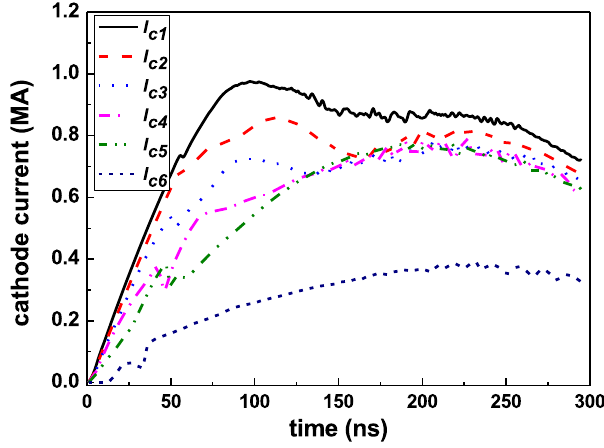
FIG. 6. Cathode currents obtained from PIC simulation. The currents were observed at cathode after each LTD group and after the final conical line for a self-limited magnetic insulation. The declined trend when approaching load indicated more and more current became electron current and flew in the anode- cathode gap.